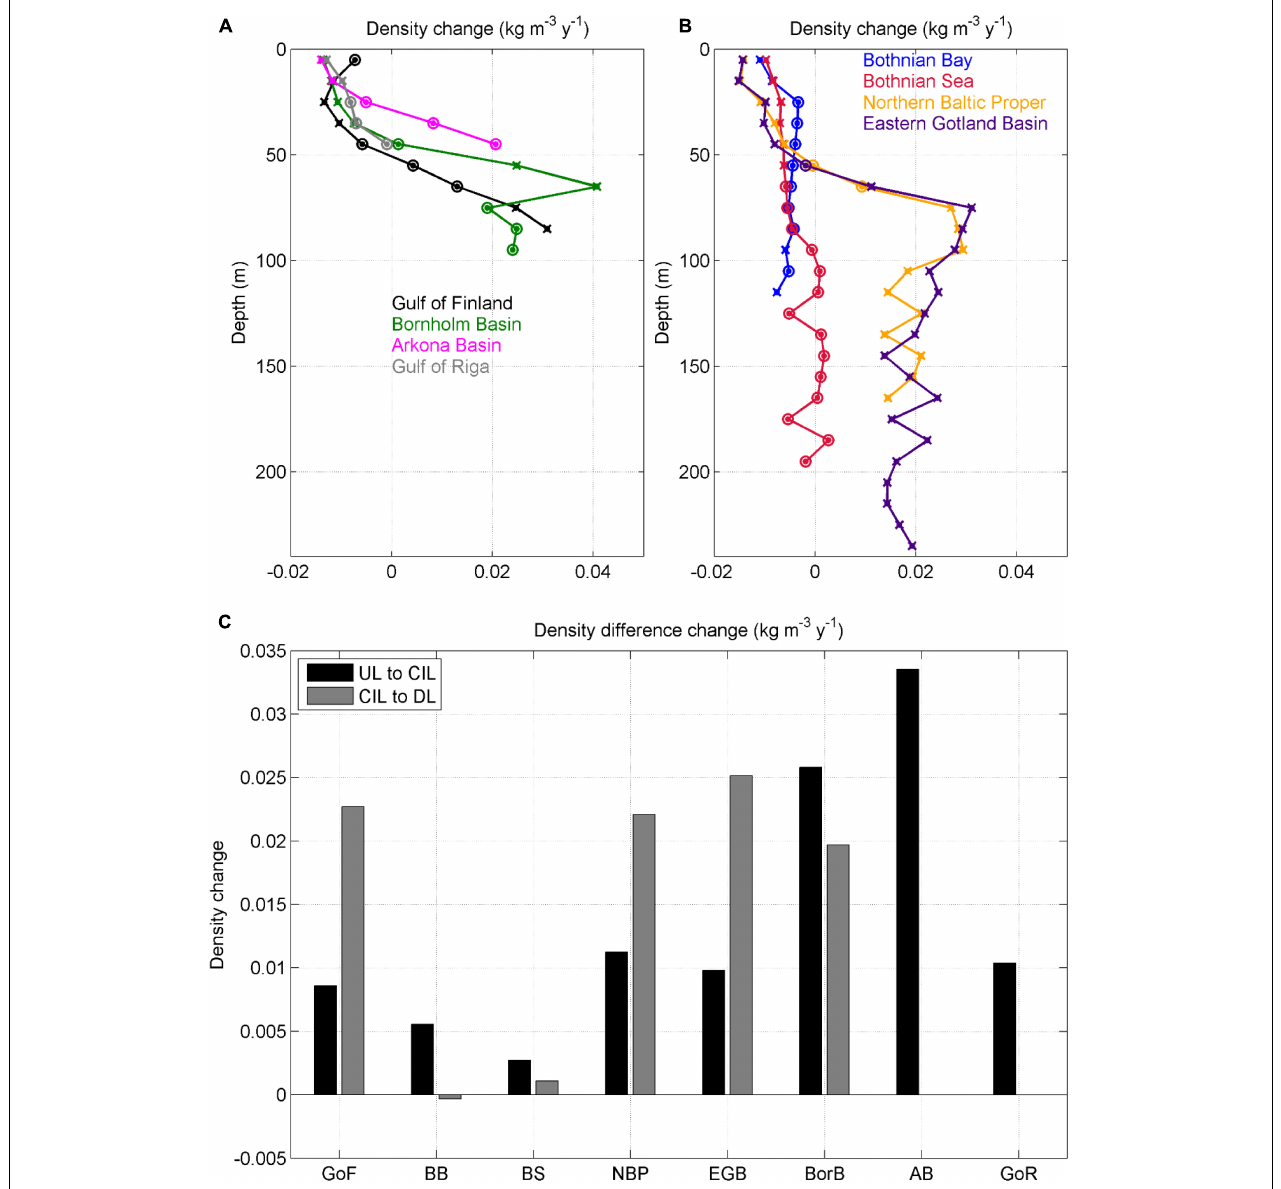
FIGURE 5 | Density trends (A,B) : trends of density differences (C) between the upper mixed layer and cold intermediate layer (UL to CIL, from 5–15 to 45–55 m), and between cold intermediate layer and sub-halocline deep layer (CIL to DL, from 45–55 to 65–85 m) in the sub-basins (GoF – Gulf of Finland, BB – Bothnian Bay, BS – Bothnian Sea, NBP – Northern Baltic Proper, EGB – Eastern Gotland Basin, BorB – Bornholm Basin, AB – Arkona Basin GoR – Gulf of Riga) of the Baltic